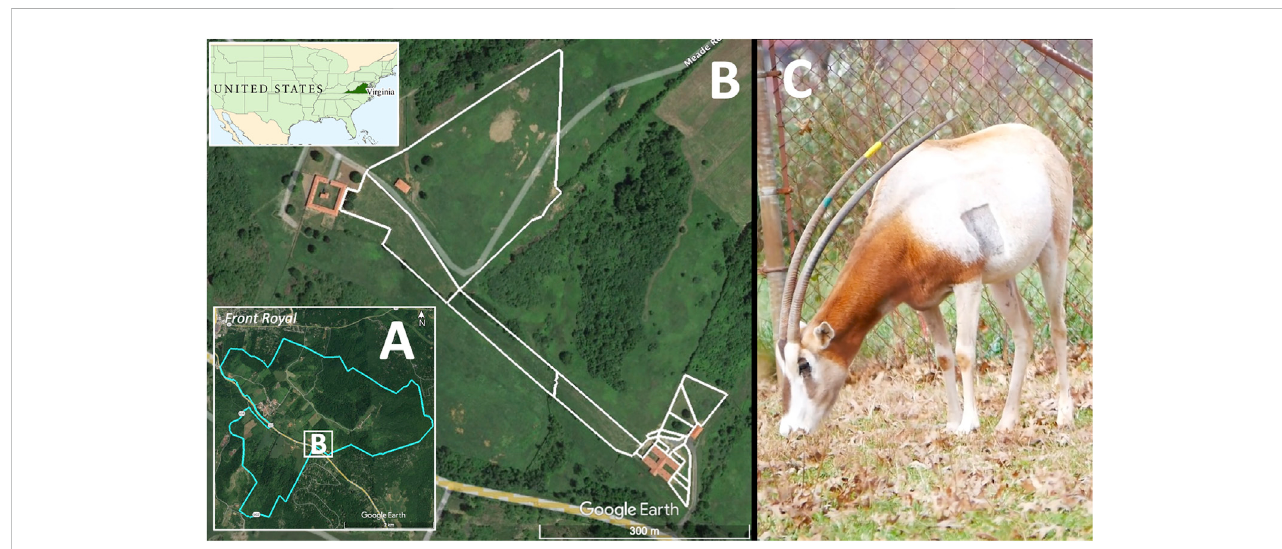
FIGURE 1 Study site location and study species. The Smithsonian Conservation Biology Institute (SCBI; 1,400 ha) (A) is located outside thetownof FrontRoyal, VA, United States, in the foothills of the Appalachian Mountains. A series of enclosures covering 7.47 ha (B) were used to manage a herd of scimitar-horned oryx, including the eight individuals for this study. Animals were provided access to fenced pasture (white delimiting lines) as well as shelters and barns. The right panel (C) shows a female scimitar-horned oryx grazing inside a fenced pasture at SCBI 6 days after being implanted with a heart monitor. The shaved rectangular spot in the left parasternal position marked the site where the biologger was injected